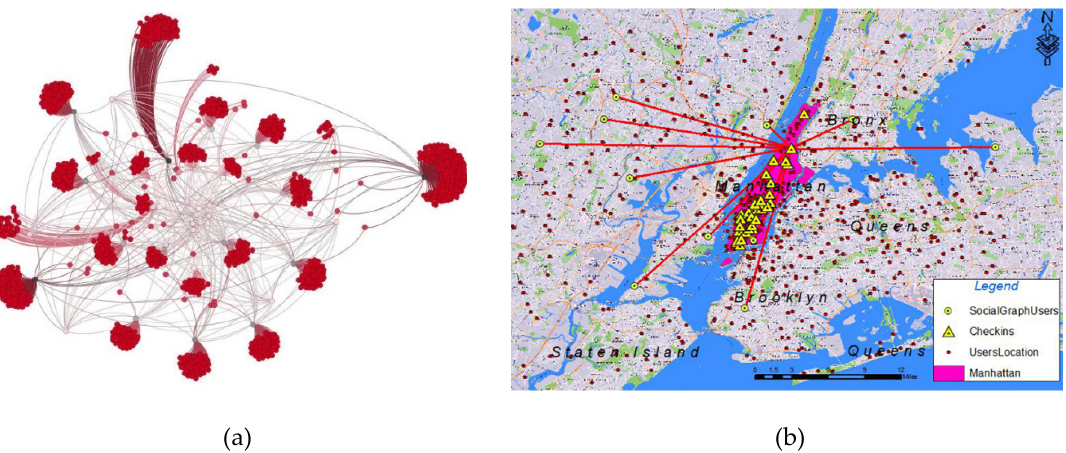
Figure 3. User distribution and clustering: ( a ) a graph representation of user clustering result by applying the ABC algorithm in the situation we do not have any other information to explicitly recognize similar users; ( b ) research geographic area which shows user geographic distribution, their check-in information, and similar users to the target user extracted from the ABC clustering as indicated by the pink solid lines.